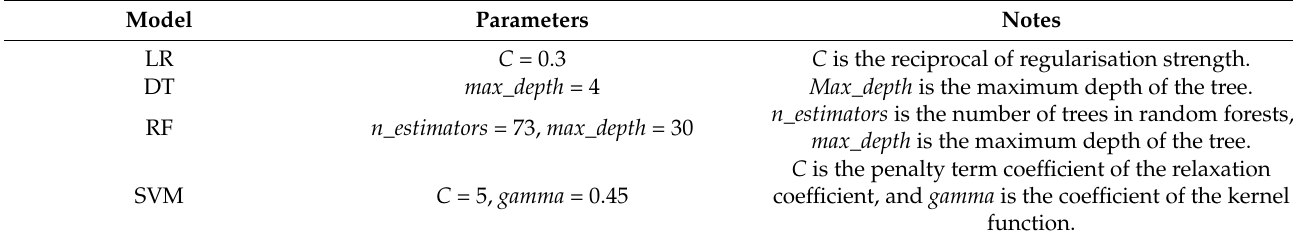
Table 5. The parameters of four